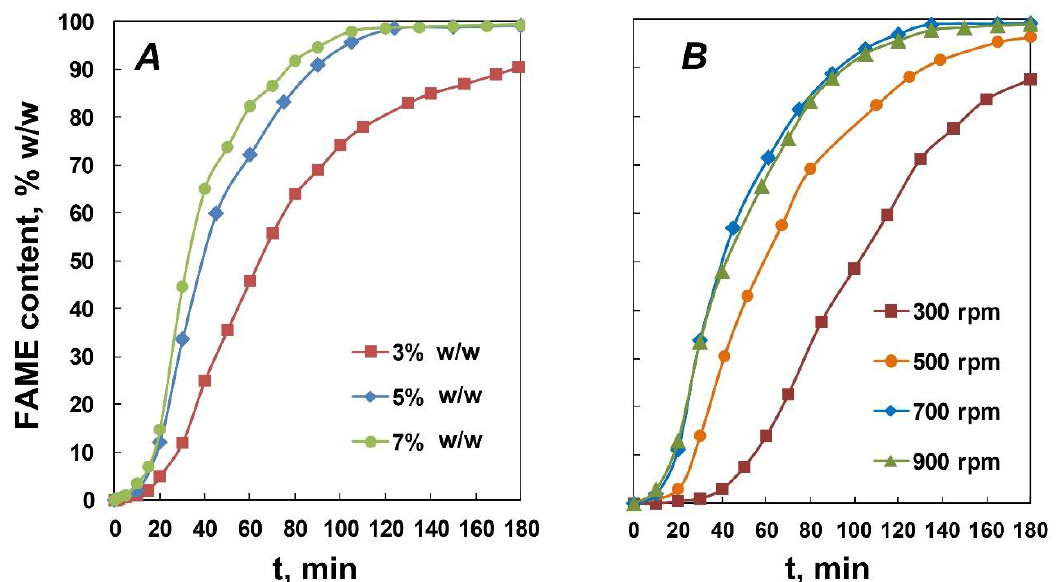
Figure 7. Effect of: ( A ) catalyst concentration (stirring rate = 700 rpm, T = 65 °C, ratio = 9:1, time = 180 min) and ( B ) stirring rate ([Catalyst] = 5%, T = 65 °C, ratio = 9:1, time = 180 min) on FAME production.